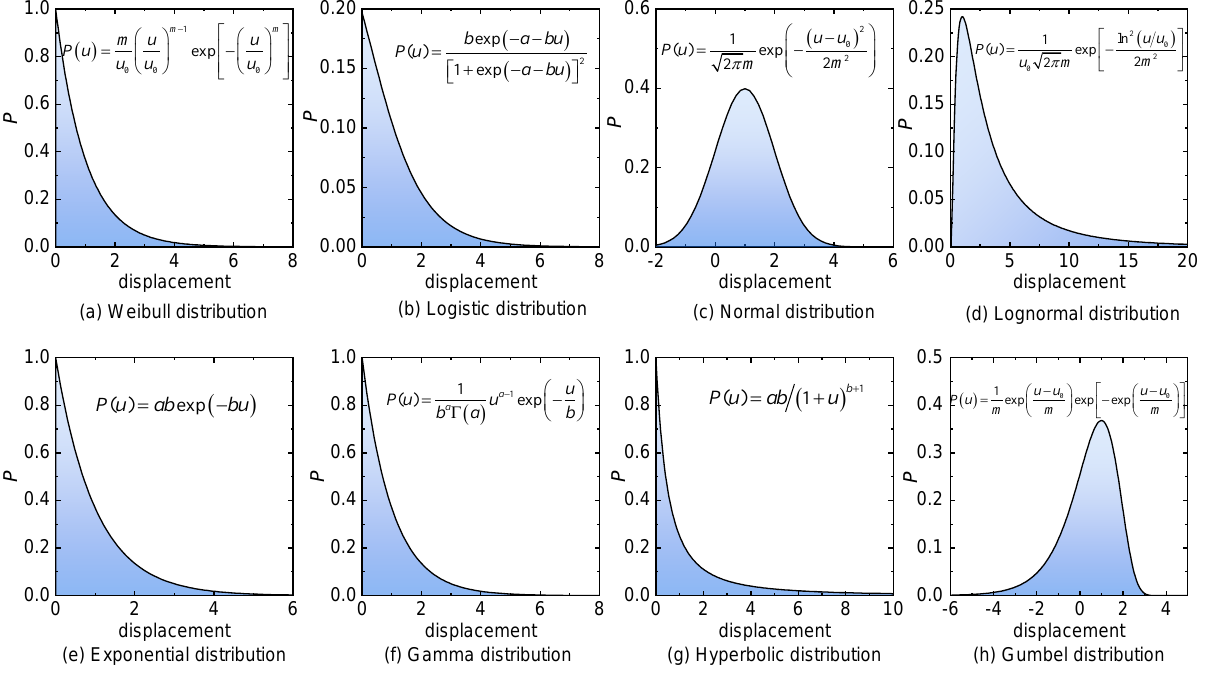
Figure 5. Microelement strength distributions of the soil material are obtained when both parameters of the statistical functions are 1. The black curve represents microelement strength distribution; the blue shaded area represents the damage variable .